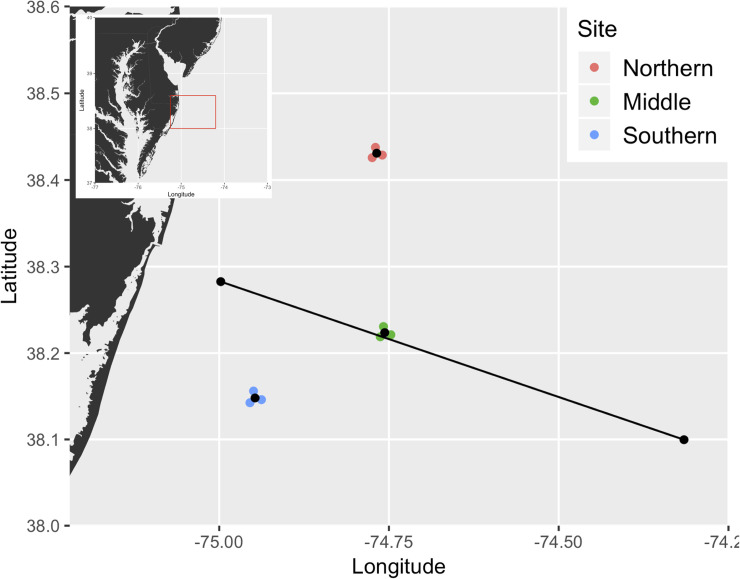
Experimental reef sites, east of the Maryland coast, for the 2016–2018 study seasons.* Colored points refer to receiver deployment locations, while black points refer to approximate tagging locations. The black line depicts the selected 38.73 km transect for cross-sectional FVCOM estimates. * Inset map provides location of study site, given as a red square, within the broader Maryland-Delaware coast.